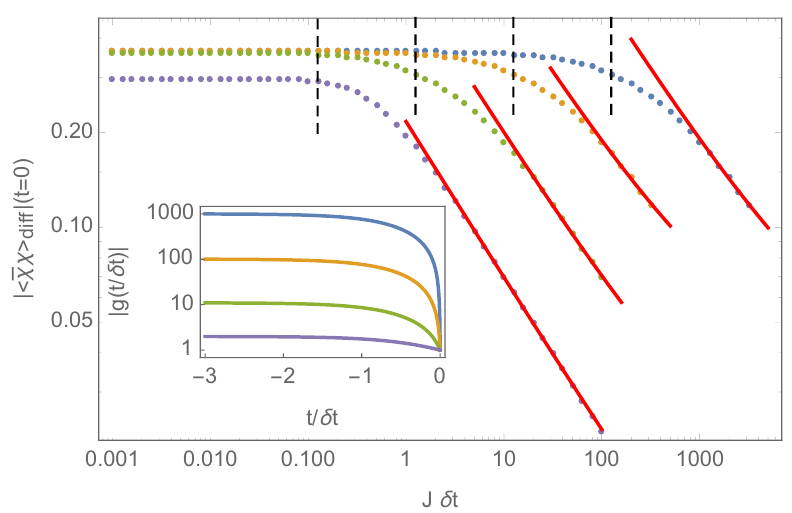
Figure 3 . The response h (cid:22) (cid:31)(cid:31) i di(cid:11) at (cid:12)xed t = 0 as a function of J(cid:14)t for the (one-dimensional) transverse (cid:12)eld Ising model, for large initial amplitudes. The time-dependences of the coupling g ( t ) are given in the inset. The red lines are the (cid:12)ts to the Kibble-Zurek scaling, P ( J(cid:14)t ) (cid:0) 1 = 2 + Q , that starts at J(cid:14)t (cid:24) j (cid:15) in j . For (cid:15) in = (cid:0) 1, P = 0 : 216 and Q = 0 : 00122; for (cid:15) in = (cid:0) 10, P = 0 : 604 and Q = 0 : 00984; (cid:15) in = (cid:0) 100, P = 1 : 595 and Q = 0 : 0299; and for (cid:15) in = (cid:0) 1000, P = 5 : 247 and Q = 0 : 0255. The black dashed lines show the expected saturation point J(cid:14)t = j (cid:15) in j = 8, in each case. quenches will saturate for J(cid:14)t (cid:20) 1 = (4 c ) or more simply J(cid:14)t . 1. 11 Hence we have